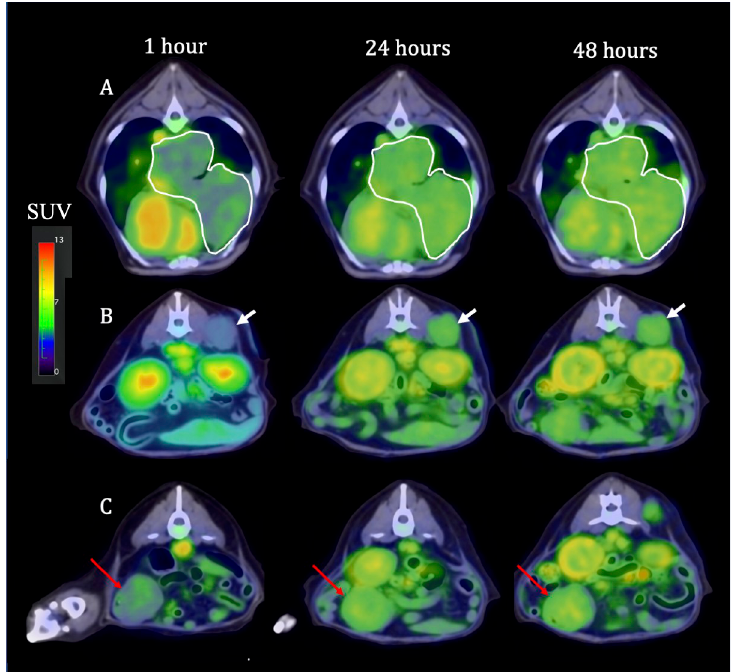
Fig 4. Tumor selective uptake of 86 Y-NM600 as documented by serial PET/CT in one illustrative case (Dog 4). 1, 24 and 48 hour axial images at the level of (A) right middle and caudal lung lobe melanoma metastasis (outlined in white); (B) right epaxial muscle melanoma metastasis (white arrow) that was used as the index tumor for external beam radiation therapy and intratumoral hu14.18-IL2 immunocytokine to create an in situ vaccination; (C) jejunal melanoma metastasis (red arrow). Note the 86 Y-NM600 is primarily in the vascular compartment at the 1 hour time point and then selectively accumulates into all metastatic sites at subsequent time points.